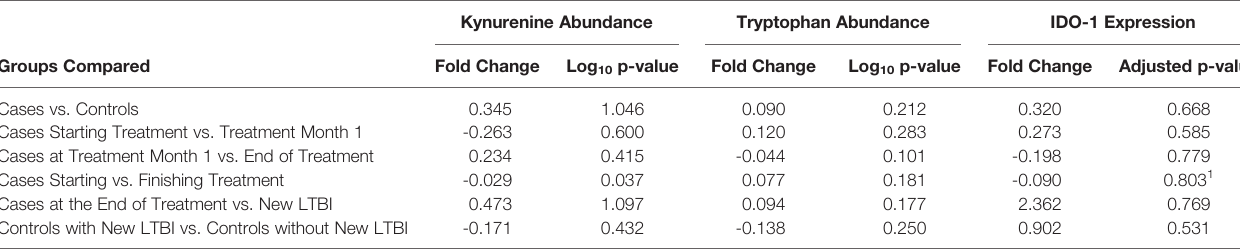
Kynurenine Abundance